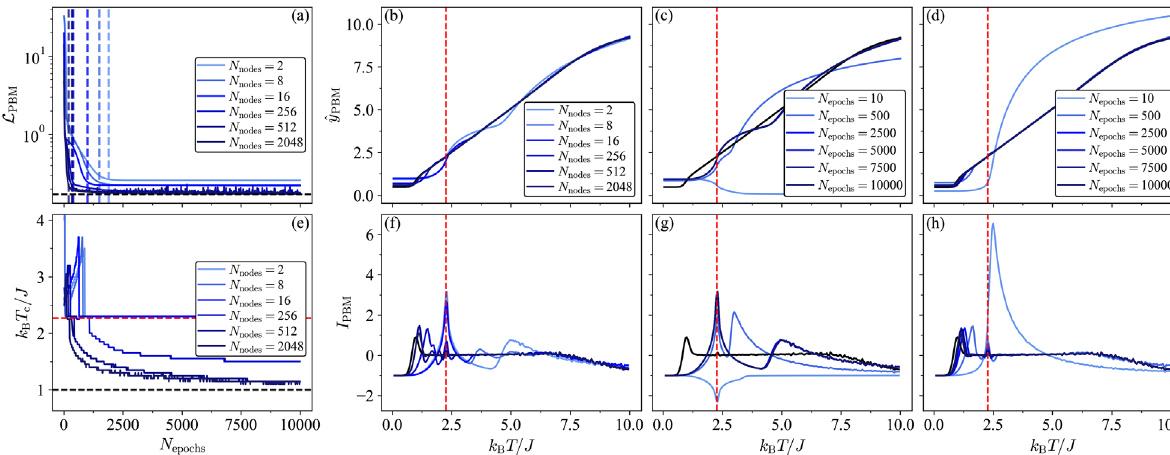
FIG. 13. Results for the Ising model ( L ¼ 60 ) of PBM using NNs with a single hidden layer composed of different numbers of hidden 10 with Δ p ¼ 0 . 05 . The critical nodes N . The learning rate is set to 0.01. The tuning parameter ranges from p 1 ¼ 0 . 05 to p K ¼ nodes k T =J is highlighted in red. The optimal predictions, optimal indicator, optimal loss, and value of the tuning parameter p c ¼ B c corresponding estimated critical value of the tuning parameter are highlighted in black. (a) Loss L as a function of the number of PBM training epochs N . The locations in kinks in the loss (as identified by eye) are marked by vertical dashed lines. (b),(f) Mean epochs p Þ of PBM obtained using NNs after training for 10 000 epochs, as well as the corresponding indicator I p Þ . (c),(g) prediction ˆ y PBM ð PBM ð 2 at various stages during training, as well as the corresponding p Þ of PBM obtained using an NN with N Mean prediction ˆ y PBM ð nodes ¼ 2048 at various stages during training, p Þ . (d),(h) Mean prediction ˆ y p Þ of PBM obtained using an NN with N indicator I PBM ð PBM ð nodes ¼ p Þ . (e) Estimated critical value of the tuning parameter as a function of the number of as well as the corresponding indicator I PBM ð training